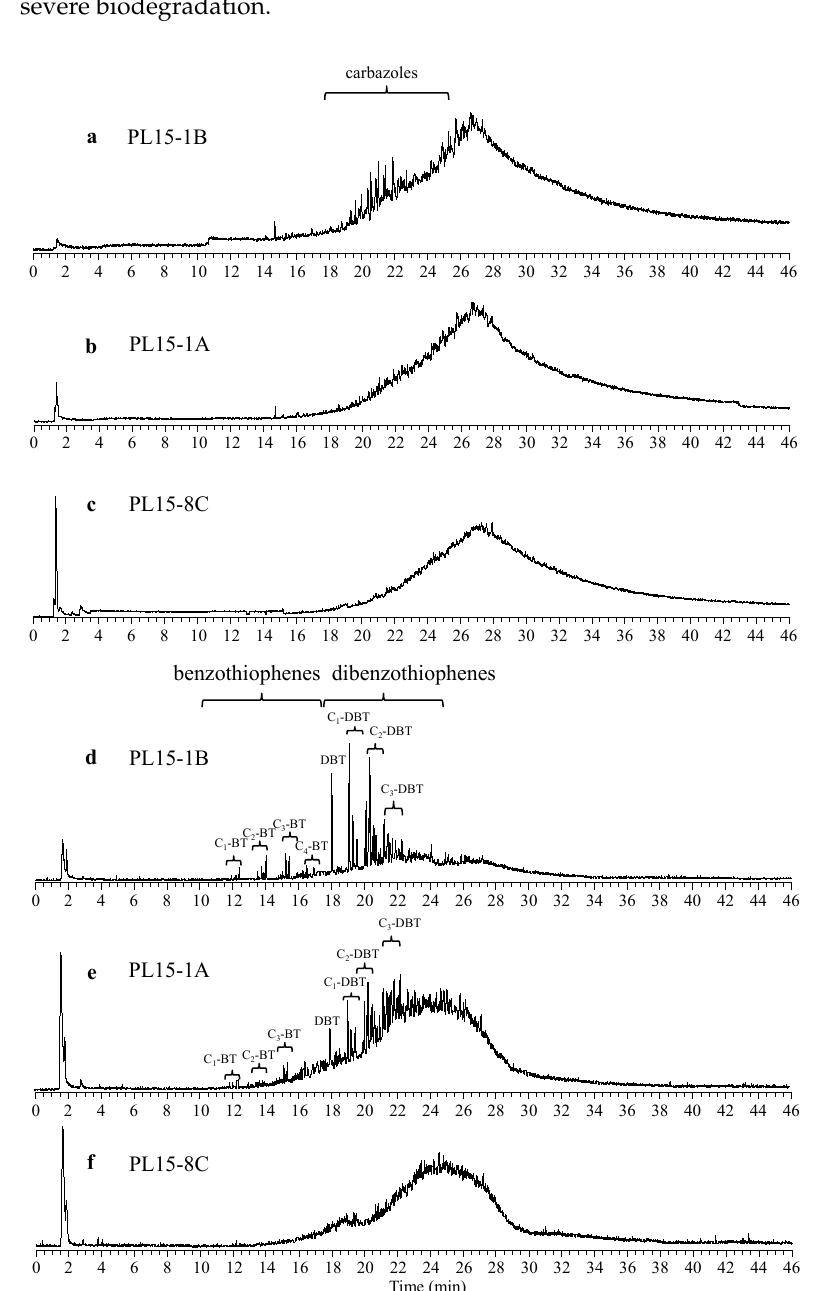
Figure 2. GC-NCD ( a – c ) and GC-SCD ( d – f ) chromatograms of the studied crude oils. Table 2. Relative abundance of heteroatomic compound classes in the studied crude oils. Species